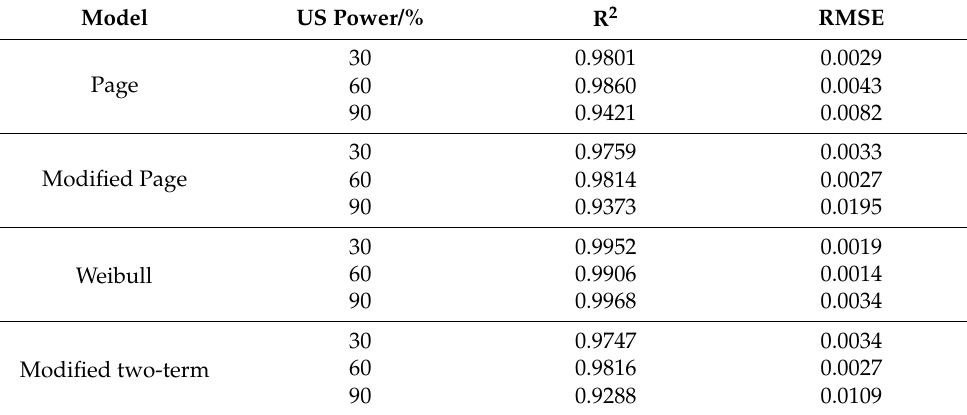
Table 4. Coefficient of determination and RMSE of selected mathematical models—60 min